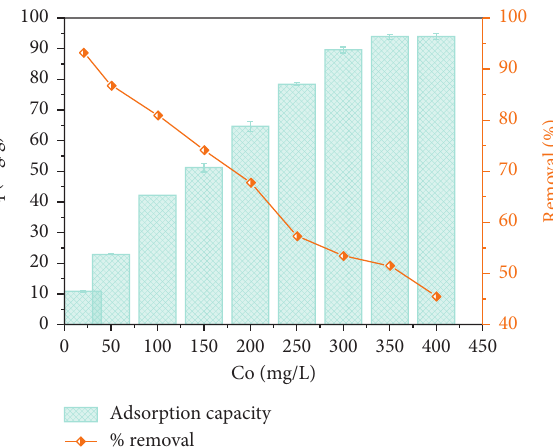
Figure 7: Effect of initial RhB concentrations on the adsorption process by CAC/CoFe 2 O 4 200 at initial pH of 4, 150min of contact time, and adsorbent dosage of